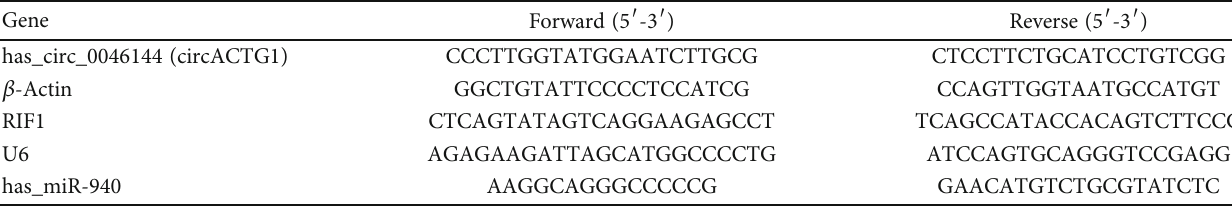
Table 1: Sequence of primers used in the